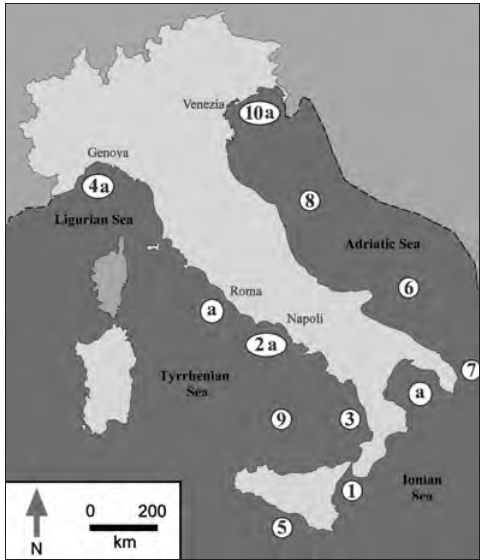
Fig. 13. Map of the nodes of the future Italian «per- manent» multidisciplinary seafloor network. The numbers indicate the sites of geophysical (particular- ly seismological and/or volcanological) interest in order of priority from 1 to 10, while the letter «a» in- dicates sites of environmental interest. The number 1 represents the SN-1 location, the first existing real- time connected